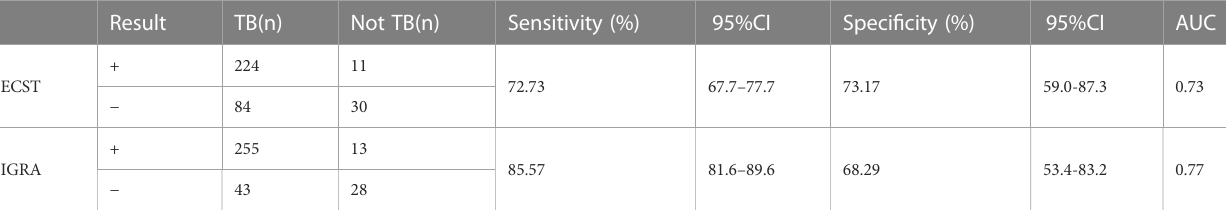
TABLE 4 Comparison of the accuracy of ECST and IGRA tests in newly diagnosed TB.